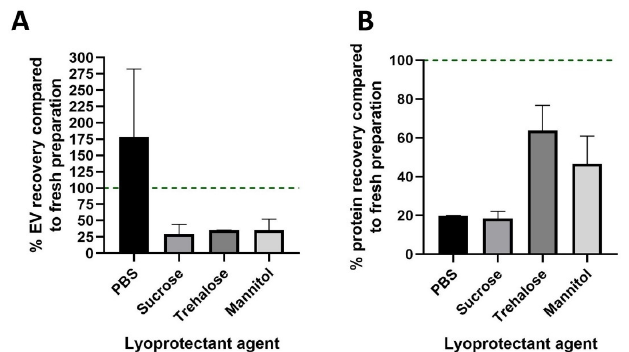
Figure 1. Characterization of the EV and protein recoveries in the manifold lyophilized MSC-SP. The secretome product (SP) was isolated from the MSC-conditioned media by tangential flow fil- tration (TFF). The diafiltrate used in TFF was altered to test four lyophilization excipients: PBS, 5% w/v sucrose, 4% w/v trehalose and 4% w/v mannitol. Lyophilized MSC-SPs were prepared using a manifold protocol and the EV and protein constituents were quantified by nanoparticle tracking analysis and BCA assay, respectively. The percentages of ( A ) EV and ( B ) protein recovered in the lyophilized MSC-SP were